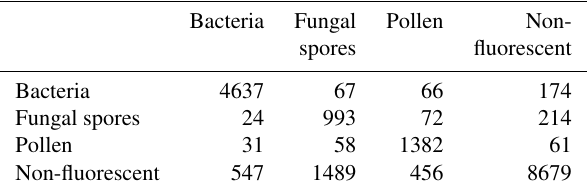
Table 4. Breakdown of error for the gradient boosting algorithm on the full data set. For example, in the third row and first column we can see 31 particles of the bacteria sampled were classified as fungal